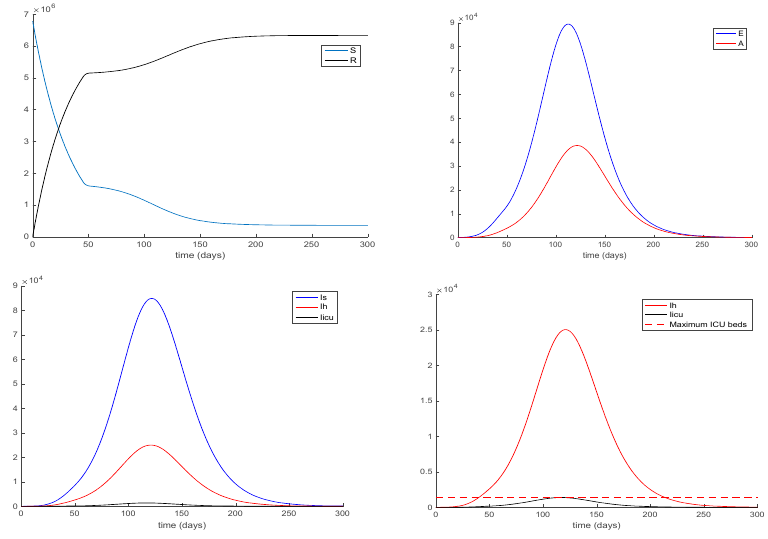
Figure 2. Evolution of the populations of the model when Programme 2 is used.